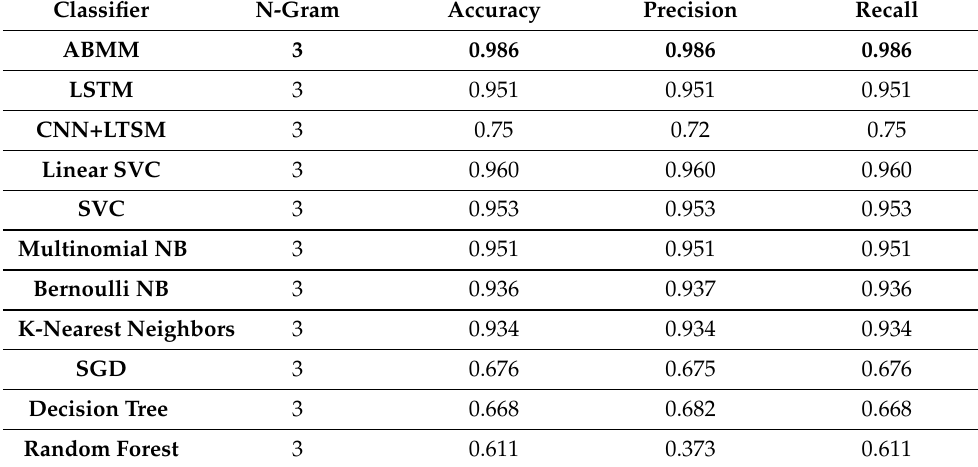
Table 6. Overall metrics for each